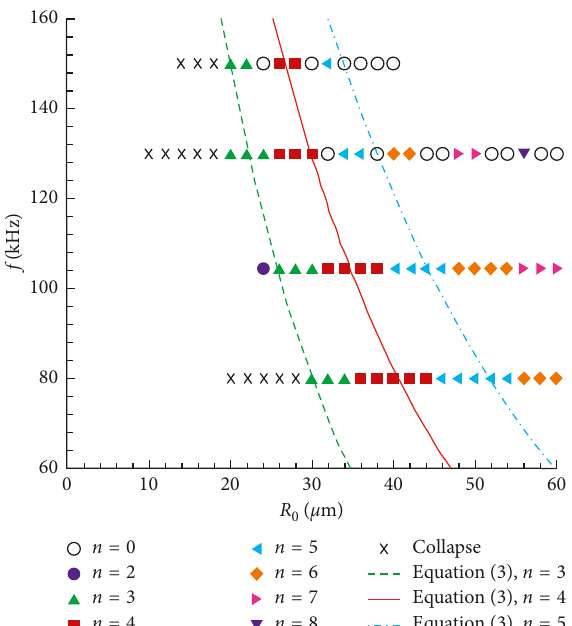
Figure 5: Mode distribution at different frequencies, when P d � 42kPa.